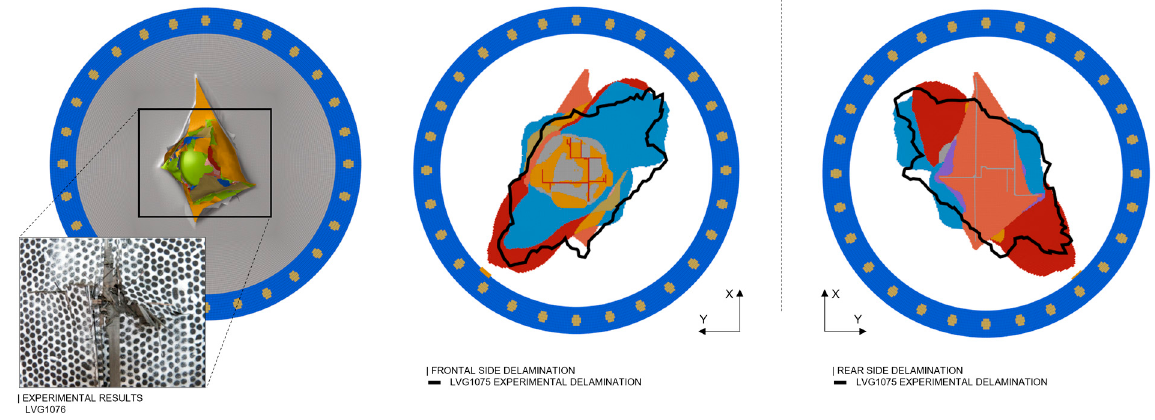
Figure 7. SX—view of the back side of the tested composite panel (LVG1076) and FE simulation at 0.75 ms; DX—predicted numerical delamination in comparison to the experimental observation of the tested composite panel (LVG1075). Each interlaminar delamination through the thickness is represented by different colors.